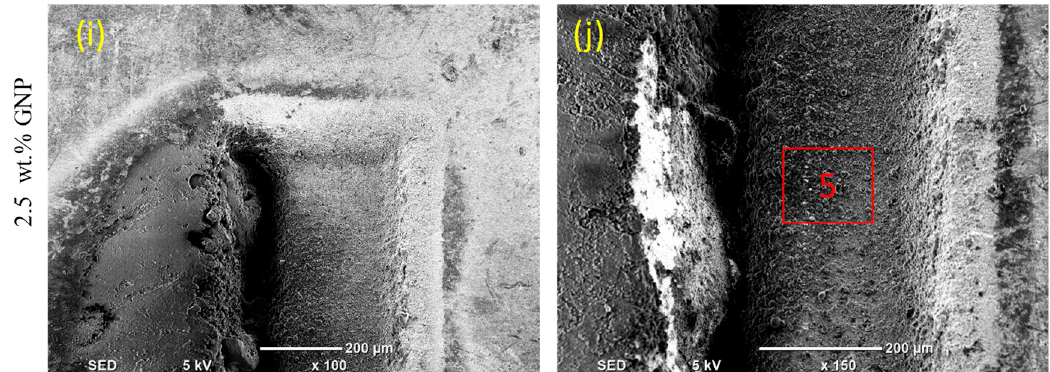
Figure 11. Surface morphologies of the ablated base Al 2 O 3 and GNP/Al 2 O 3 nanocomposites with varying graphene contents at 500 mm/s.